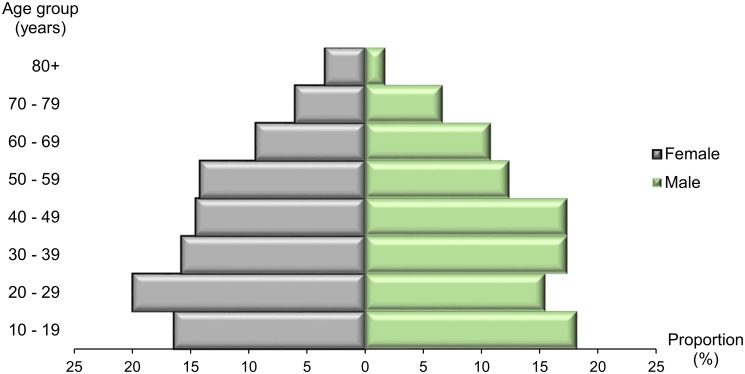
Age distribution of the study population.